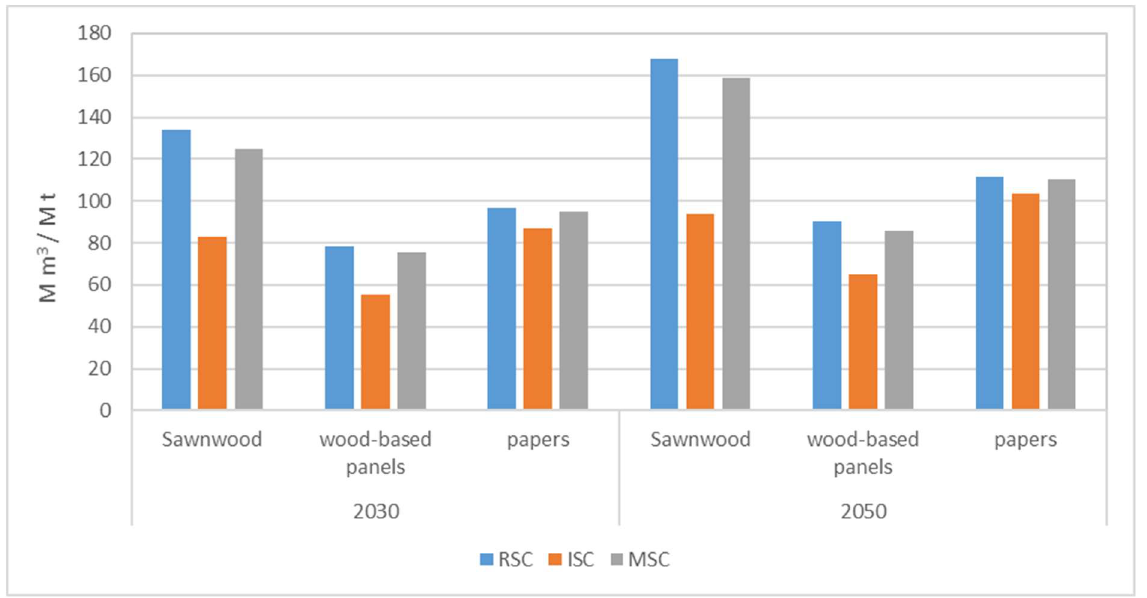
Figure 5. EU production of wood-based products by sectors in RSC (blue), ISC (orange) and MSC (grey). Wood-based materials comprises veneer and plywood as well as particle and fiberboard; papers include newsprint, printing and writing paper and paper and paperboards [authors’ results].